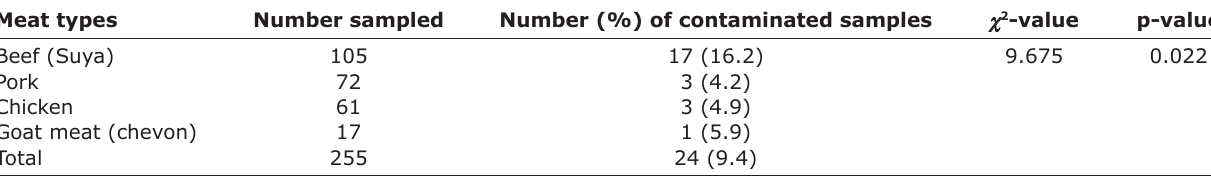
Table-1: Staphylococcus contamination of ready-to-eat meats according to meat types. Meat types